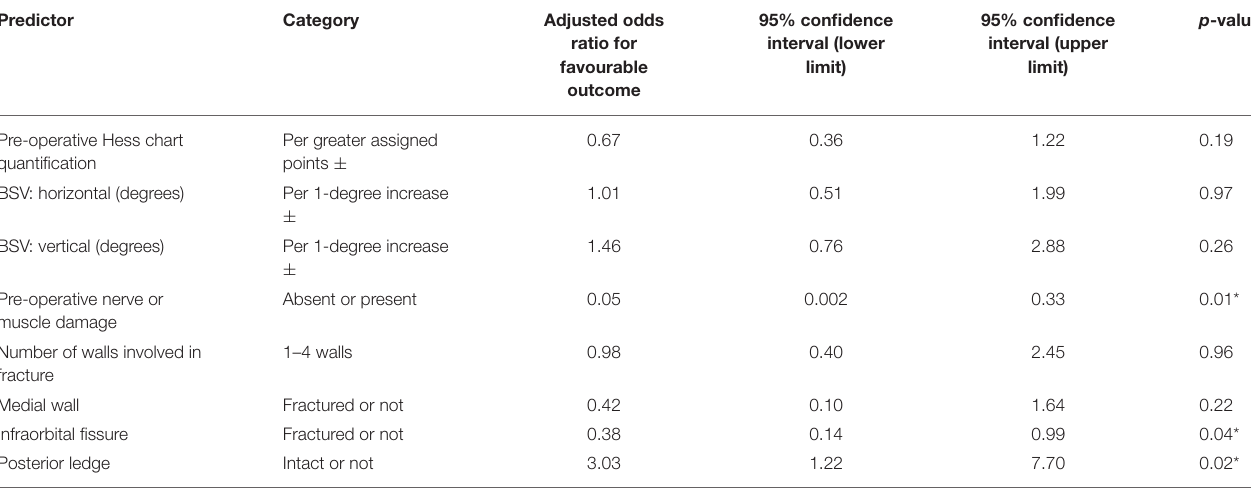
TABLE 4 | Adjusted effect variables on successful outcome at 6 months.